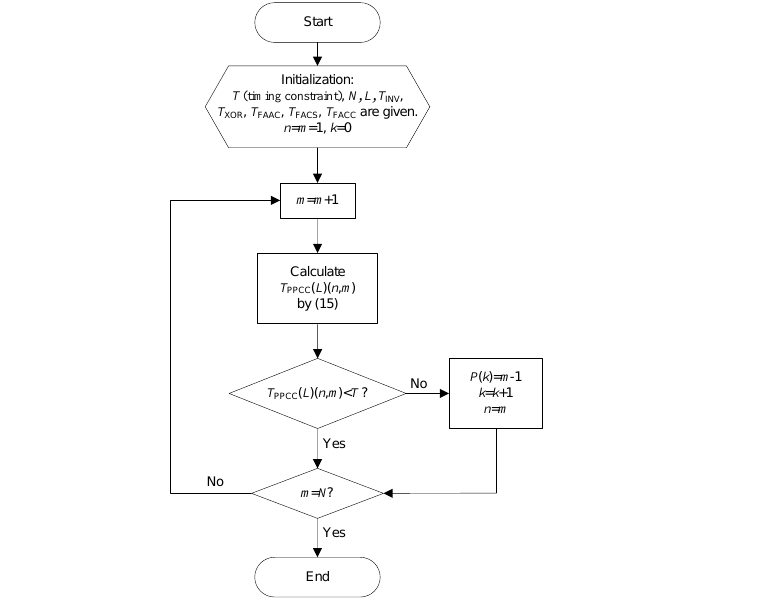
Figure 3. The algorithm used to determine number of pipeline stages and to choose locations of pipeline registers in the cascaded